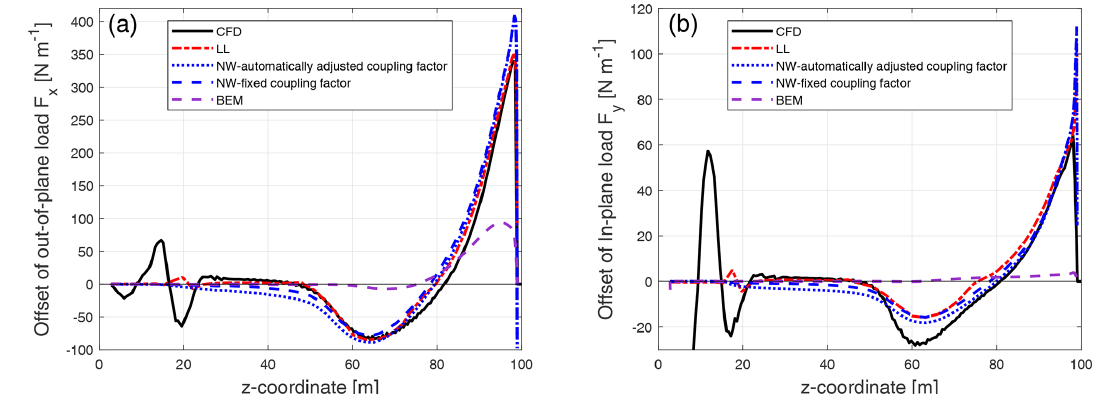
Figure 9. Comparison of the difference between the out-of-plane load (a) and the in-plane load (b) of the backward swept Blade-1 with respect to the baseline blade calculated from the Navier–Stokes solver (CFD), the lifting-line method (LL), the proposed coupled method (NW) and the blade element momentum method